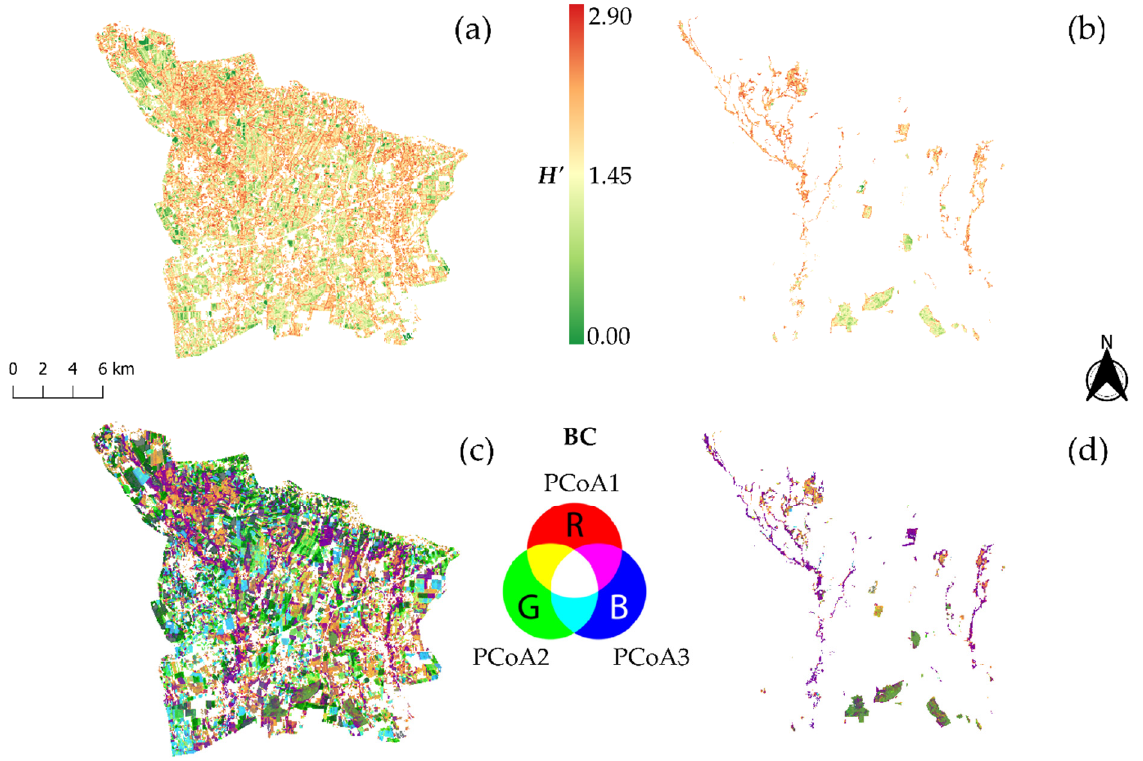
Figure 2. Spectral α diversity map, expressed as Shannon index (H’), of the study area ( a ) and of the EN nodes ( b ). Spectral β diversity map, expressed as Bray–Curtis dissimilarity index (BC), produced by the projection of the n × n dimensional space of the dissimilarity matrix into an n × 3 dimensional space (PCoAs), of the study area ( c ) and of the EN nodes ( d ). Similar colors, resulting from the PCoA ordination, represent similar spectral plant communities.